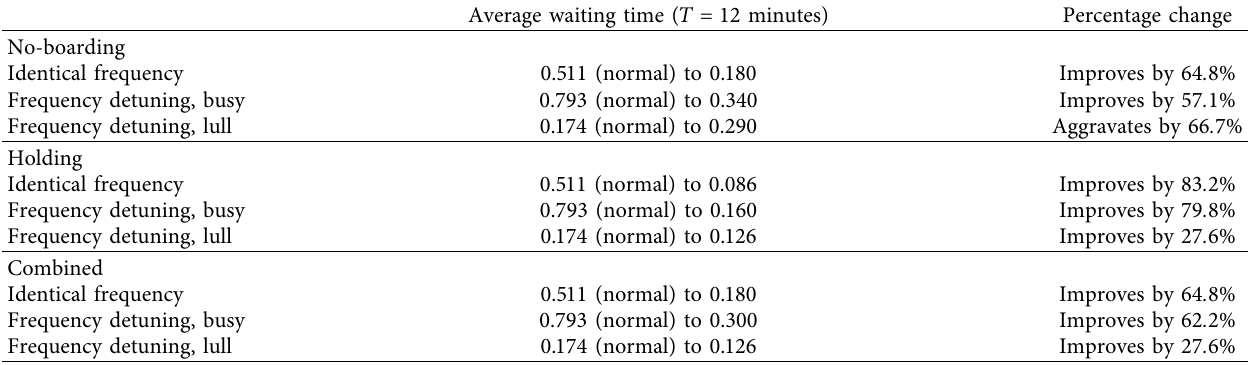
Table 2: Quantitative performance of the no-boarding strategy, holding strategy, and a combination of them, respectively, in various setups of N � 6 buses serving M � 12 bus stops in a